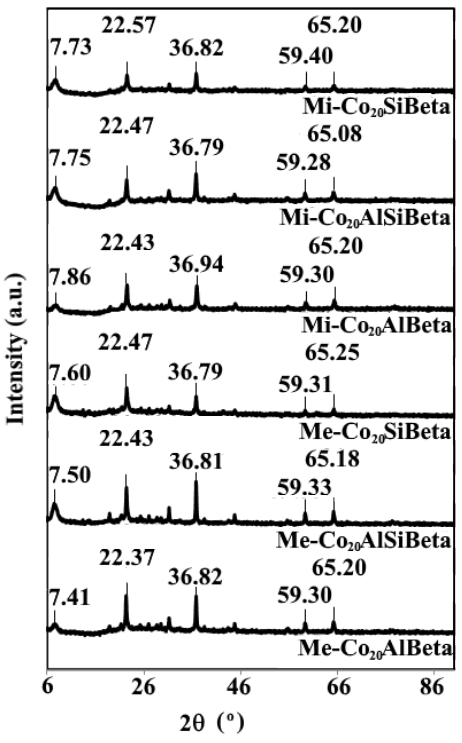
Figure 1. X-ray diffractograms measured at room temperature and ambient atmosphere of Me-Co 20 AlBeta, Me-Co 20 AlSiBeta, Me-Co 20 SiBeta, Mi-Co 20 AlBeta, Mi-Co 20 AlSiBeta and Mi-Co 20 SiBeta.